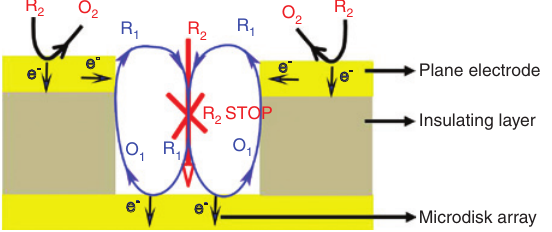
Figure 7: A schematic diagram of the working principle for selective detection of reversible species against irreversible species using plane-band-recessed microdisk electrode array systems. R is the target analyte, and R 1 2 are target and interfering species,